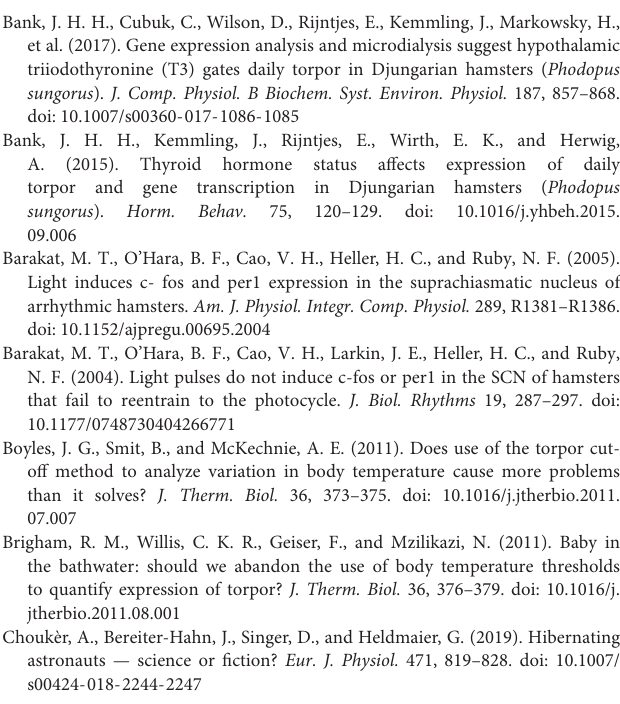
2. Yellow marked hamsters did not express spontaneous daily torpor. Sparklines in the last column indicate the individual change, with the hamster’s highest value as 100% and its lowest as 0%. Supplementary Table 6 | Activity values per time frame, week in long photoperiod (LP) and short photoperiod (SP) as well as individual of approach 2. Yellow marked hamsters did not express spontaneous daily torpor. Sparklines in the last column indicate the individual change, with the hamster’s highest value as 100% and its lowest as 0%. Supplementary Table 7 | Activity ratio values per time frame, week in long photoperiod (LP) and short photoperiod (SP) as well as individual of approach 2. Yellow marked hamsters did not express spontaneous daily torpor. Red color marks ratios above 1.0 indicating diurnal activity patterns (upper part) or higher activity during the second half of the scotophase (lower part). Sparklines in the last column indicate the individual change, with the hamster’s highest value as 100% and its lowest as 0%. Second to first half of scotophase ratio was not raised for LP with a scotophase of eight hours. Supplementary Table 8 | Adaptation parameter values per week in long photoperiod (LP) and short photoperiod (SP) as well as individual of approach 2. Yellow marked hamsters did not express spontaneous daily torpor. Sparklines in the last column indicate the individual change, with the hamster’s highest value as 100% and its lowest as